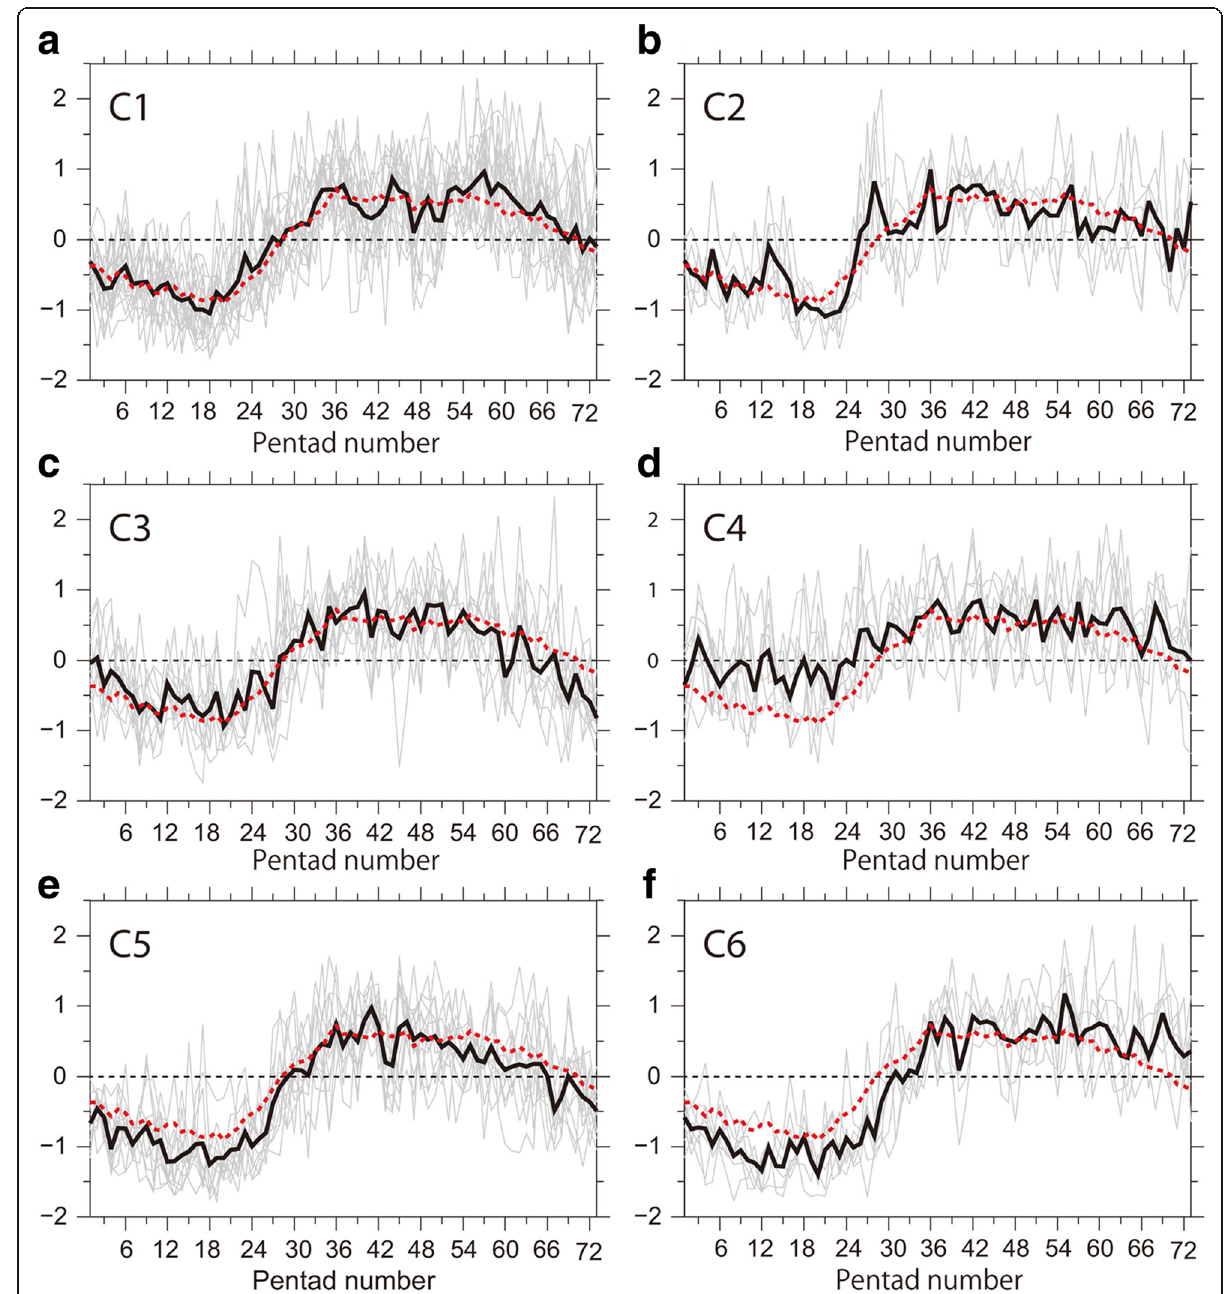
Fig. 3 a – f Classification of patterns of the time coefficients of EOF1 using cluster analysis. The dotted red line and thick solid black line indicate the mean time coefficients averaged for 1951 – 2012 and for the years classified in each cluster ( a C1, b C2, c C3, d C4, e C5 and f C6), respectively. The gray thin line indicates the time coefficients in each